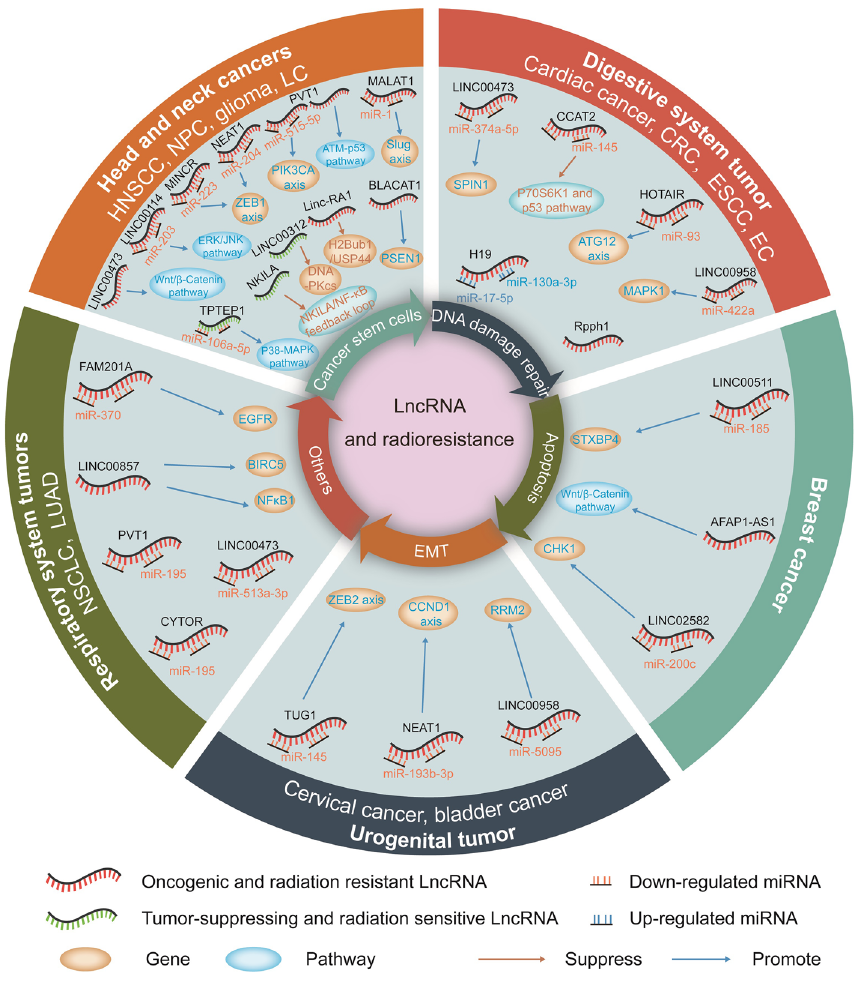
Figure 2. The mechanisms and targets of lncRNAs involved in regulating radiosensitivity and radioresistance in various types of malignant